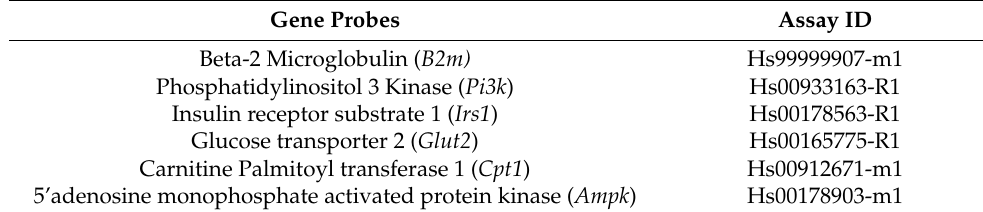
Table 1. List of gene expression probes used in this